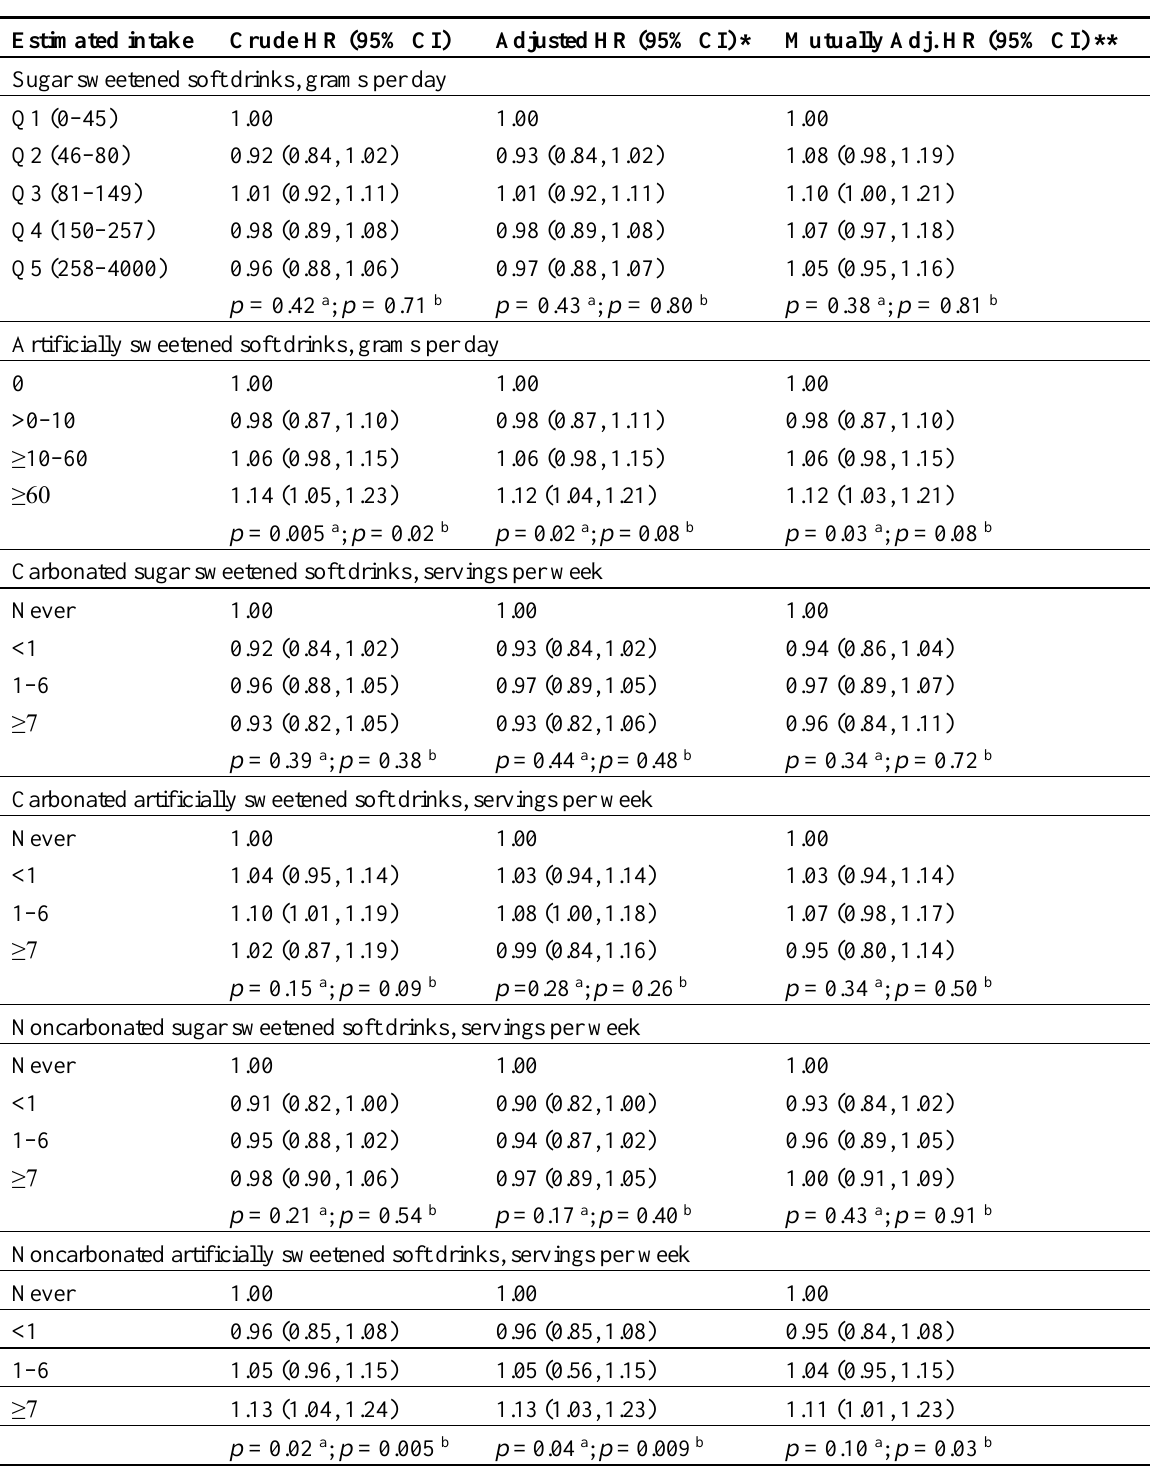
Table 4. Hazard ratios (HRs) of offspring forearm fractures in the Danish National Birth Cohort according to maternal intake of soft drinks in mid-pregnancy ( n =